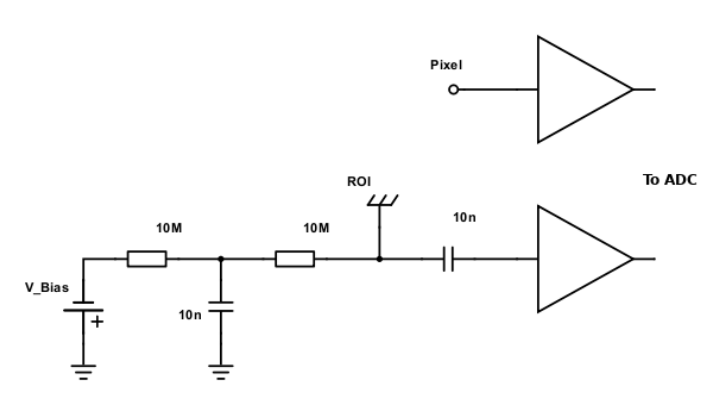
Figure 2. Circuit diagram for pixels and inductive focusing grids that form the Regions Of Interest (ROIs). Pixels are directly coupled to the preamplifiers. ROIs are coupled to the preamplifiers via a 10nF capacitor, and are connected to the bias voltage via a 10M Ω resistor and a low-pass RC filter used to remove AC ripples from the DC bias. The filter consists of another 10M Ω resistor and a 10nF capacitor to